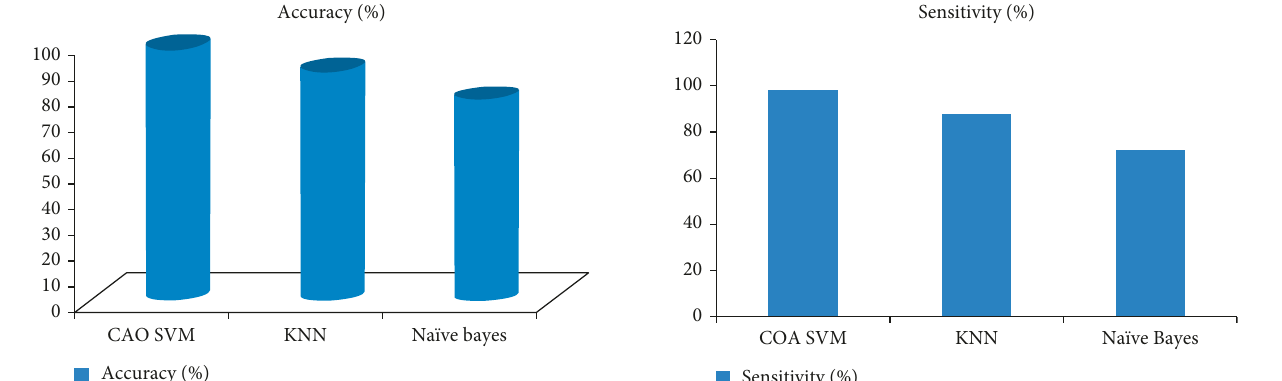
Figure 2: Accuracy of classifiers for perishable food identification. Figure 3: Sensitivity of classifiers for perishable food identification.